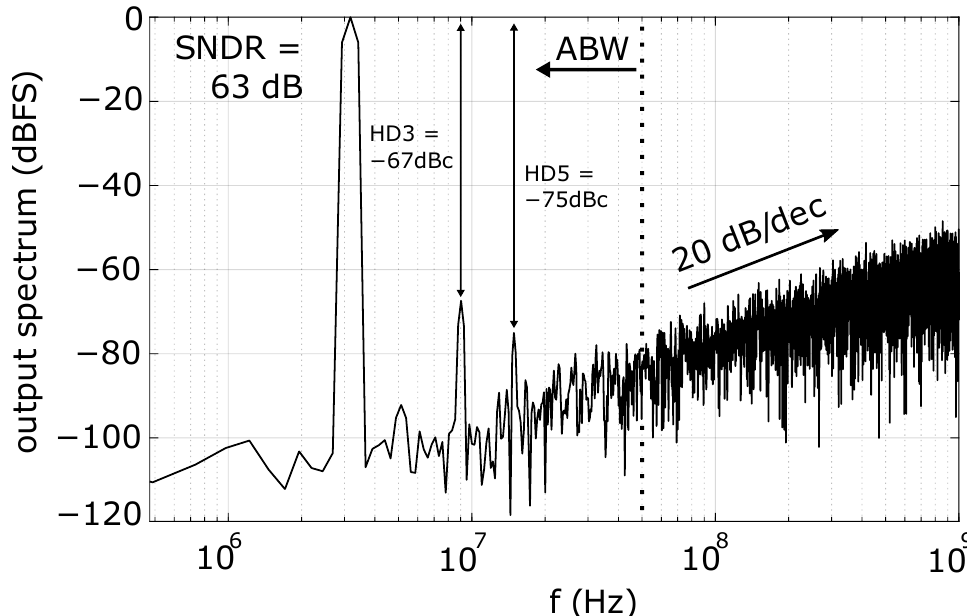
Figure 8. Output spectrum of transient simulation of the circuit proposed in Figure 6.